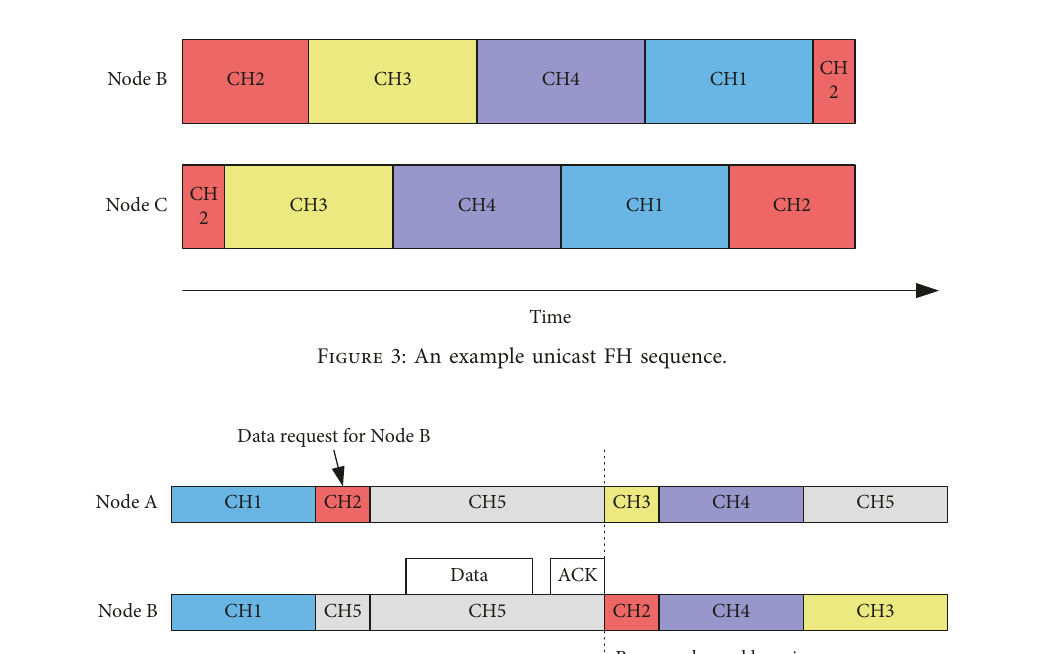
Figure 4: Receiver-directed transmissions.